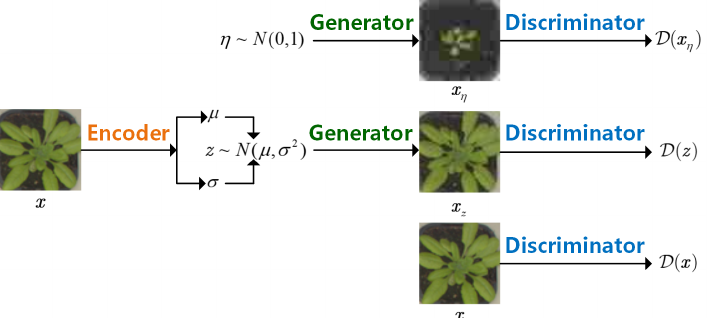
Figure 2. The framework of EnGe-CSNet. The Encoder is used to find the low dimension latent vector z of image x . The Generator is used to reconstruct images. The Discriminator is used to distinguish real and erroneous